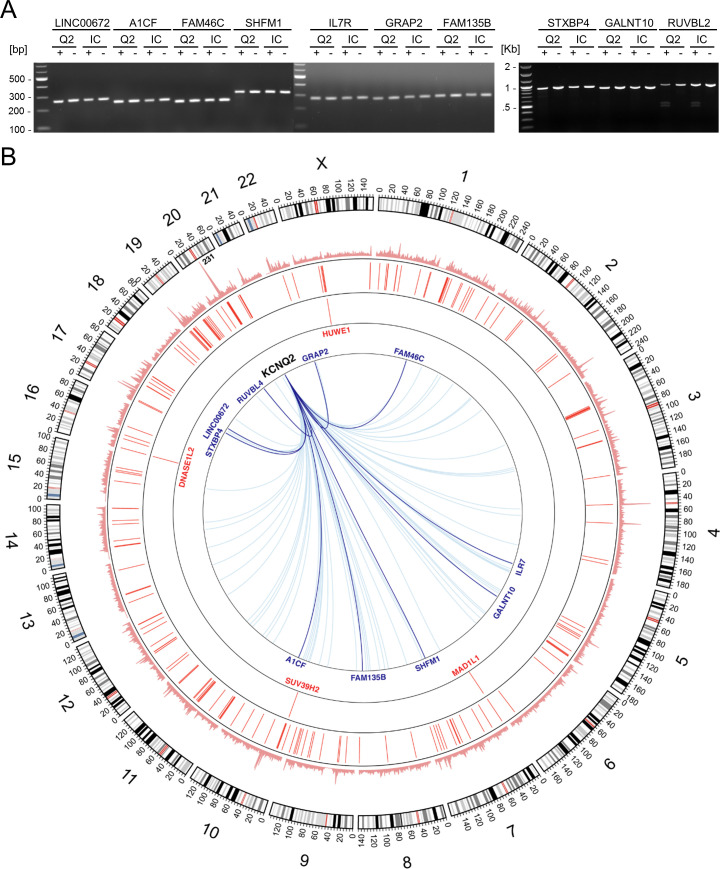
CRISPR off-target and whole genome sequencing analysis of iPSC lines.(A) Analysis of potential CRISPR off-target sites. The top ten genomic regions of homology with the CRISPR/Cas9 targeted region (Supplementary file 1) were analyzed by a T7 endonuclease assay (Supplementary file 2). No mutations were identified. (B) Whole-genome distribution of variant mismatches between the sequenced samples shown in Circos plot. WGS analysis identified 3,343,903 single nucleotide variants (SNVs) and small indels with at least one alternative allele in either of the two samples. Genotype mismatches were found for 50,736 variants (outer track), corresponding to the 1.57% of the total number of comparable positions across common and rare variants based on gnomAD (Genome Aggregation Database Consortium et al., 2020) or 0.002% across the entire genome (assuming 3 billion nucleotides). After annotation and functional prediction, we found 400 potentially deleterious variants, with 4 (1 SNV and three indels in genes labeled in red) being homozygous reference for Q2-04R581Q/+ and heterozygous for isoQ2-04+/+ and the rest 396 (223 SNVs and 173 indels) were heterozygous for isoQ2-04+/+ and homozygous reference for Q2-04R581Q/+ (second track; Supplementary file 3). Genotype comparison with in-house unrelated whole-genome sequenced samples showed that the four above-mentioned variants are only observed in the isoQ2-04+/+ sample and the other 396 are only seen in the Q2-04R581Q/+ sample, indicating that the four are likely to be newly introduced variations in the isogenic line and the 396 are likely to be sequencing artifacts. Genes overlapping the depicted potentially deleterious variants are shown in red and predicted CRISPR off-target sites are shown as blue lines (the top 10 in dark blue and the rest 63 in light blue).